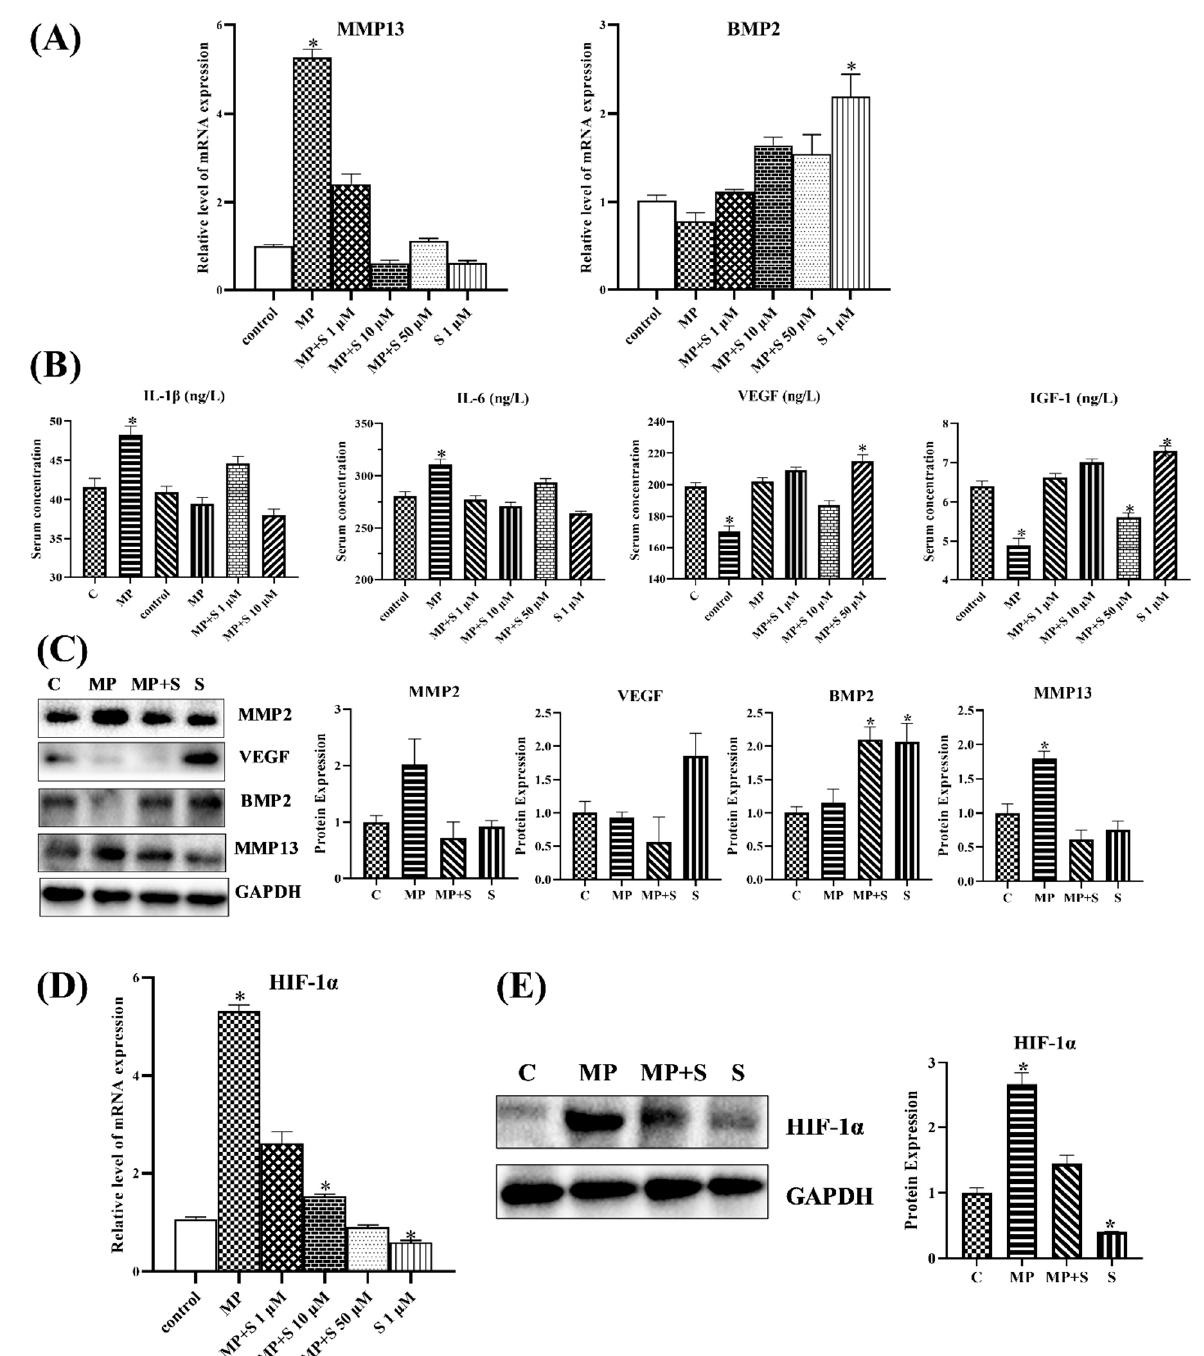
Figure 6. The changes in cartilage homeostasis and the HIF pathway in chondrocytes. ( A ) The mRNA expression of BMP2 and MMP13 in chondrocytes. ( B ) The changes in catabolic cytokines and anabolic cytokines in cell supernatant with different treatments. ( C ) The protein expression of homeostasis-related factors in chondrocytes. ( D ) The mRNA expressions of the HIF pathway in chondrocytes. ( E ) The protein expressions of HIF-1 α in chondrocytes. Here, * p < 0.05 vs. control group.